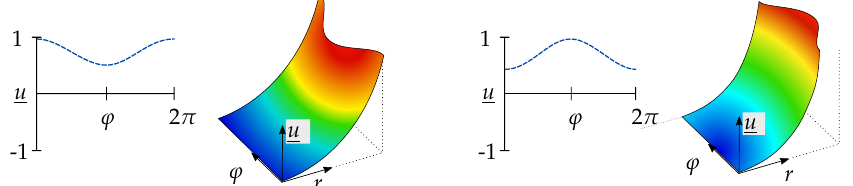
Figure 4. Mode shape (1,1) of a disc after decomposition into Z ERNIKE parts for two different extraction positions; the maximum value of the right mode shape exhibits a phase shift of π compared to the left. Without consideration of the rotational symmetry of circular discs u ( ϕ = 0 ) = u ( ϕ = 2 π